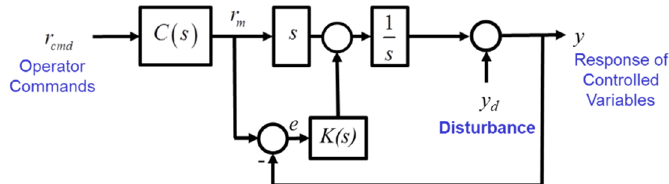
Figure 2. Simplified single-input single-output (SISO) dynamics following ideal feedback linearization.